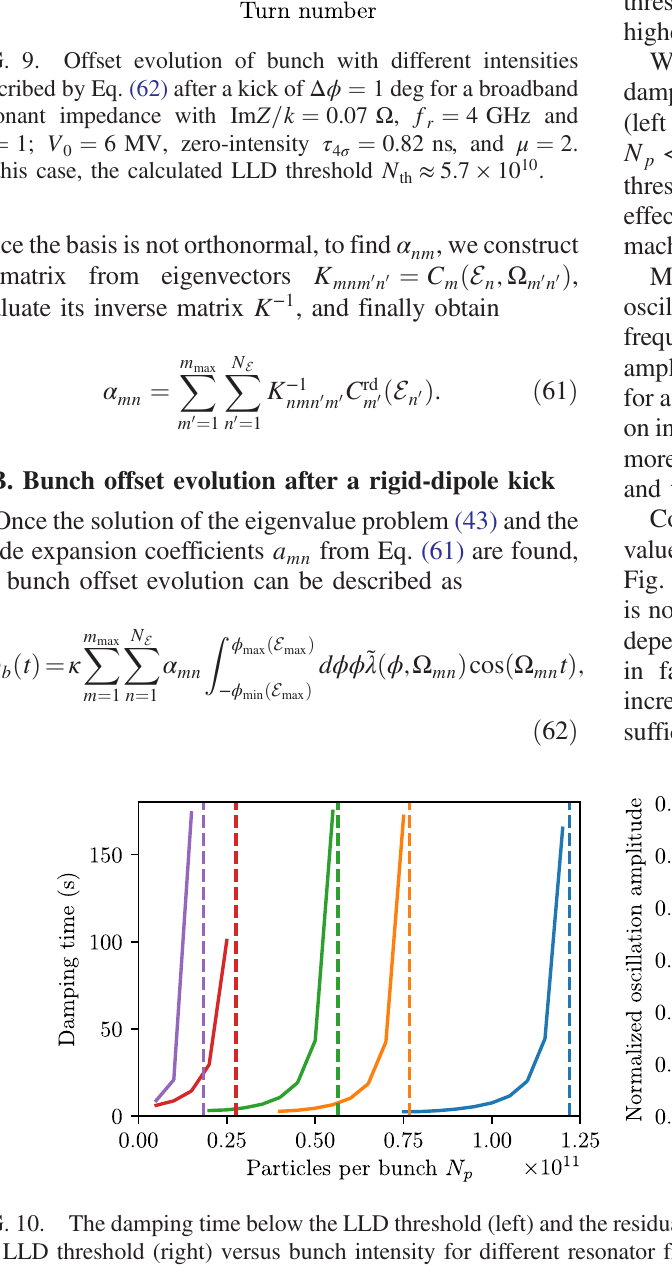
. Other parameters are the same as in Fig. 9. r